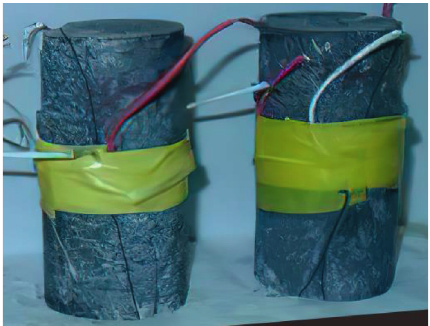
Figure 1: Rock failure under the uniaxial compression test.